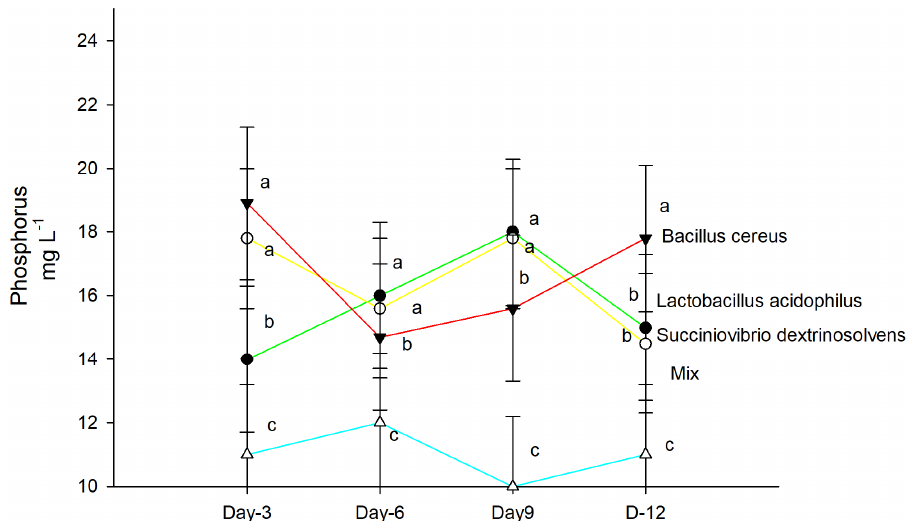
Figure 4. Dynamic of solubilized phosphorus content from the test tube on three, six, nine, and twelve days with three repetitions for each bacterium every three days. Means with different letters indicate significant differences among treatments. Statistical analysis was performed using Duncan’s test ( p ≤ 0.05). Black triangle = B. cereus ; Black cicle= L. acidophilus ; white circle= S. dextrinosolvens; white triangle = Mix.